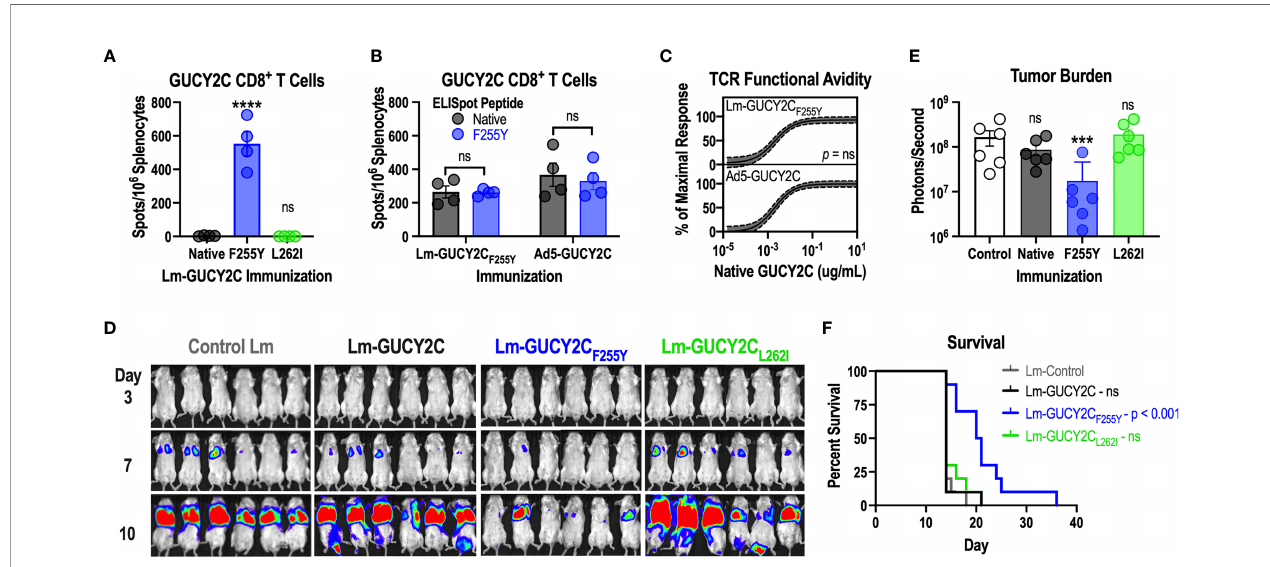
FIGURE 5 | Lm-GUCY2C F255Y primes GUCY2C-speci fi c CD8 + T-cell responses and antitumor immunity. (A) BALB/c mice (n=4/group) were immunized i.p. with 10 7 CFU of Lm secreting native GUCY2C or GUCY2C with altered GUCY2C 254-262 epitopes, and GUCY2C 254-262 -speci fi c T-cell responses were quanti fi ed 7 d later by IFN g ELISpot. (B, C) BALB/c mice (n=4/group) were immunized i.p. with 10 7 CFU of Lm-GUCY2C F255Y or i.m. with 10 10 vp of Ad5-GUCY2C and euthanized 7 or 14 d later, respectively. (B) Splenocytes from immunized mice were pulsed with native GUCY2C 254-262 peptide or GUCY2C F255Y peptide to assess the magnitude of responses by IFN g ELISpot. (C) Splenocytes from immunized mice were pulsed with decreasing concentrations of native GUCY2C 254-262 peptide to assess functional TCR avidity. Nonlinear regression (solid line) of GUCY2C-speci fi c CD8 + T-cell avidity is depicted with 95% con fi dence intervals (dashed lines). Statistical comparison was made by extra sum-of-squares F Test. (D – F) BALB/c mice (n=10/group) were immunized i.p. with 10 7 CFU control, GUCY2C, GUCY2C L262I , or GUCY2C F255Y Lm. Seven days later, mice were challenged with the CT26 colorectal cancer cell line expressing GUCY2C and luciferase. (D) Tumor burden was monitored by bioluminescence imaging and quanti fi ed on day 7 (E) . (F) Survival was monitored longitudinally. Data were analyzed by one-way (A, E) or two-way (B) ANOVA with Bonferroni correction for multiple comparisons to compare 1 or 2 variables, respectively. Error bars indicate mean +/- SEM. Survival (F) was analyzed by the Mantel-Cox log rank test with all immunized groups compared to control with Bonferroni correction. Symbols indicate individual animals. ***P < 0.001; ****P < 0.0001; ns, not signi fi